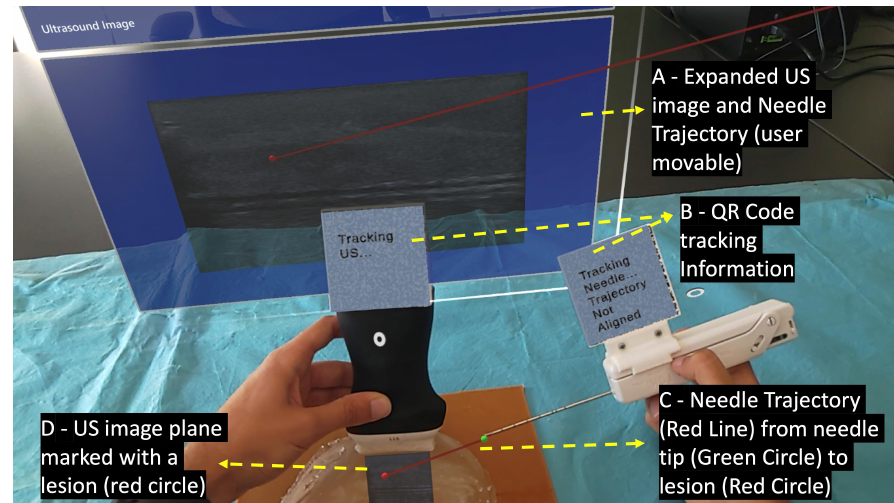
Figure 3. User’s point of view performing the biopsy procedure with the AR